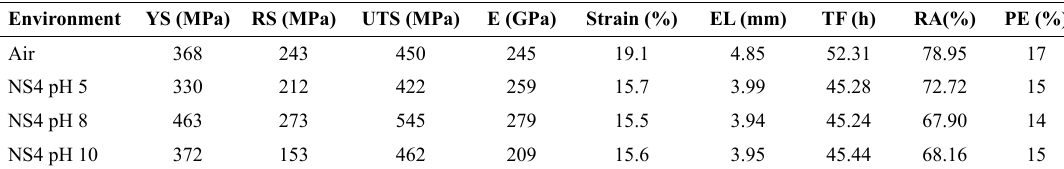
Table 3. Summary of the mechanical properties obtained from SSRT of X52 steel.